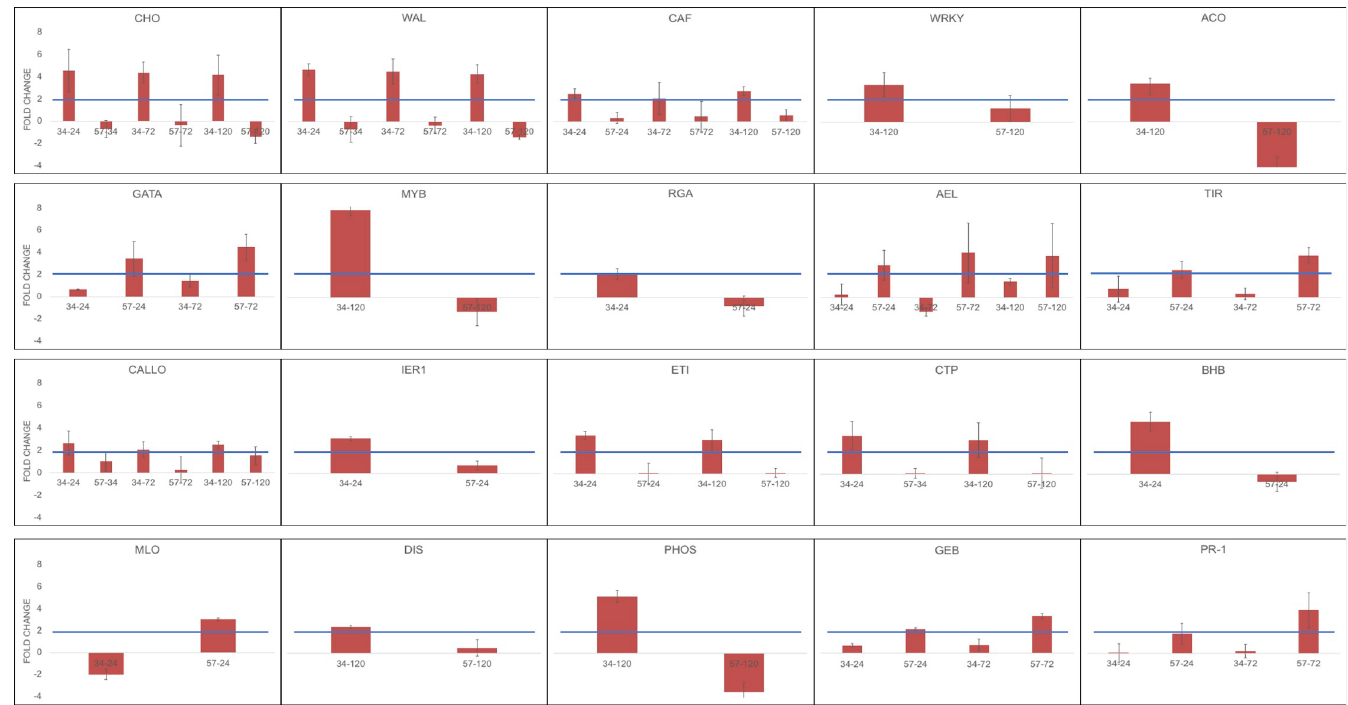
Fig 9. qRT-PCR validation of candidate genes. Each graph represents the fold change obtained by qRT-PCR, including the ortet and its inoculation time according to expression profile of each gene. CHO: Chorismate synthase. WAL: Wall-associated receptor kinase. CAF: caffeoylshikimate esterase. WKRY: WRKY transcription factor 40. ACO: 1-aminocicloprppane-1-1carboxylate oxidase. GATA: GATA transcription factor. MYB: MYB transcription factor. RGA: resistance gene analog. AEL: acidic endochitinase-like. TIR: transport inhibitor response 1 like. CALLO: callose synthase. IER1: immediate early response. ETI: ethylene insensitive 3. CTP: CTP synthase. BHB Transcription factor bHLB. MLO. DIS: disease resistance protein. PHOS: 1-phospatidylinositol-3-3phosphate 5 kinase. GEB: glucan endo-1,3-beta glucosidase- like. PR-1: pathogen related.